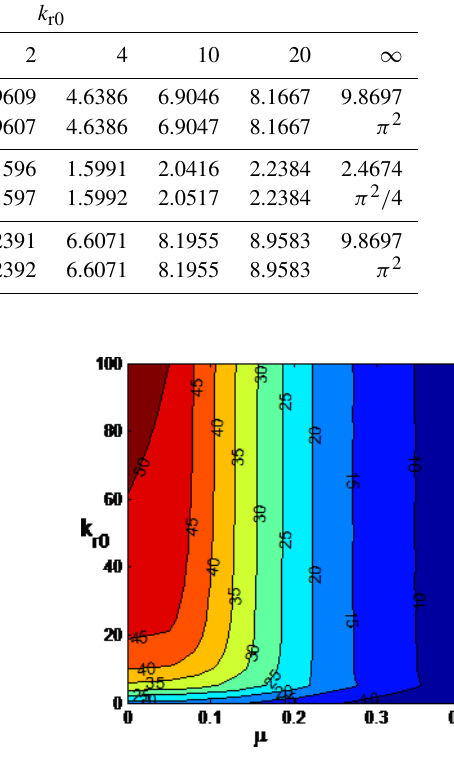
Figure 3. Contour plot of the buckling load q ( p = 0) with respect to µ and k r0 with k r1 = 0, k t = 10 8 (SS at x = L ).